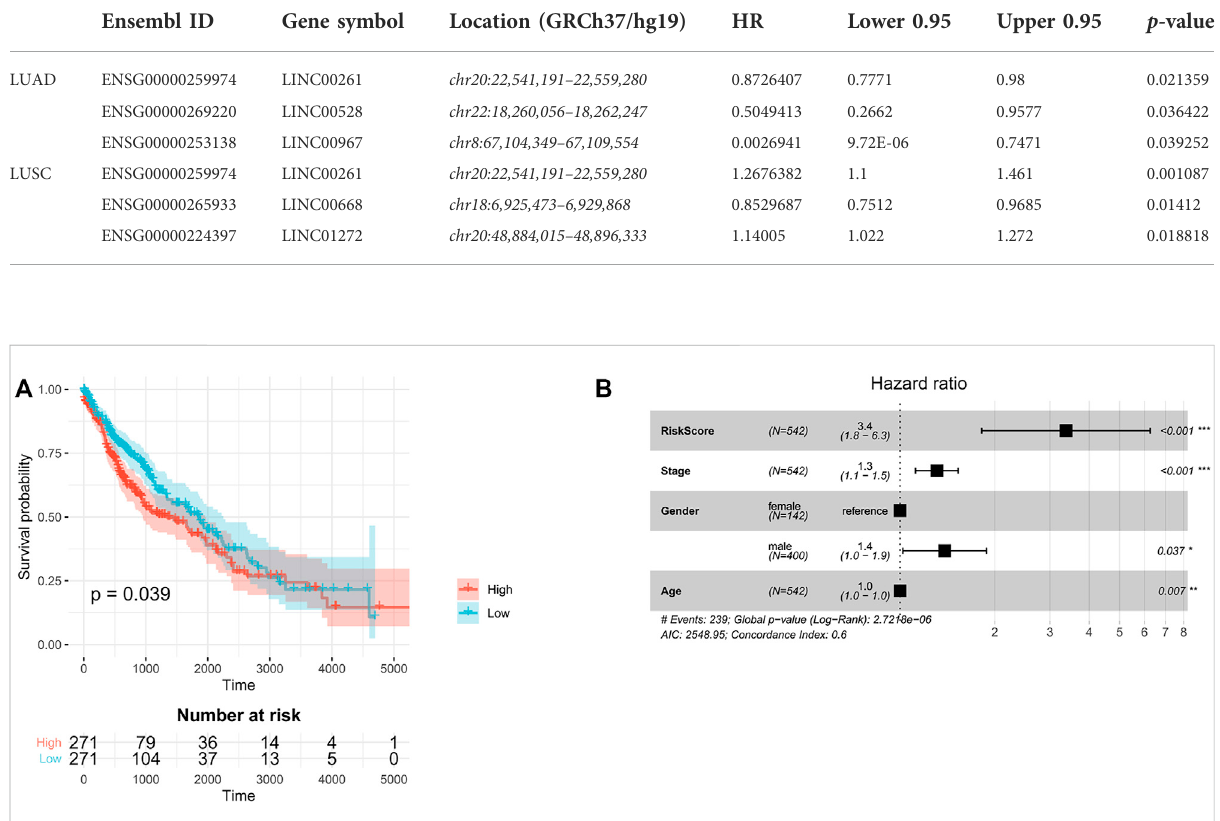
TABLE 1 Detailed information of six lncRNAs in the TANlncSig.